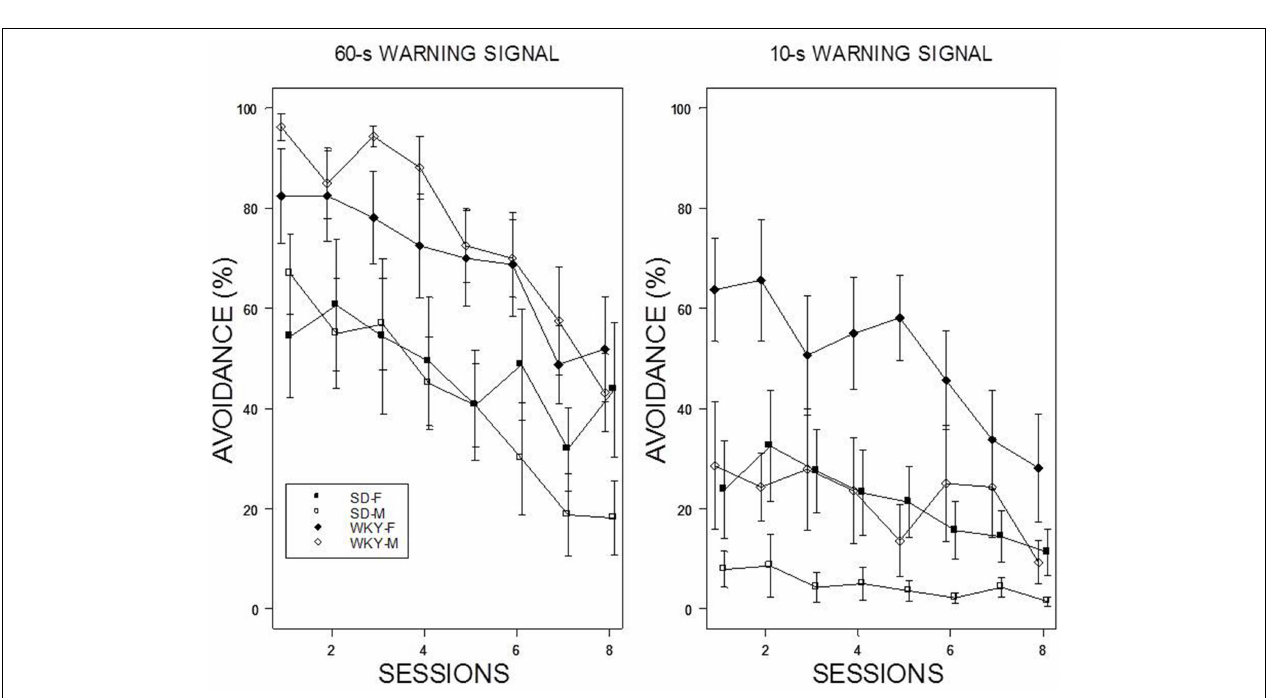
to increases in shock experienced (comparison of right panel of Figure 2 to left panel of this figure). Only female WKY rats reduced the number of shocks received from the 1st session of re-acquisition to the 8th session of re-acquisition.